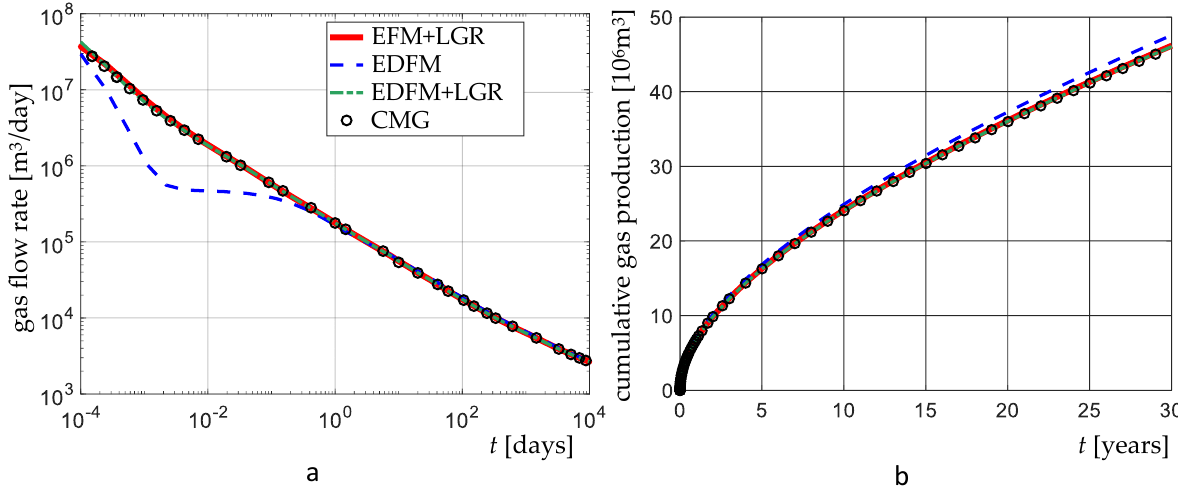
Figure 13. Comparison of the results provided by ShOpen and CMG in terms of ( a ) gas flow rate and ( b ) cumulative production, for VE1B with C f 10,000